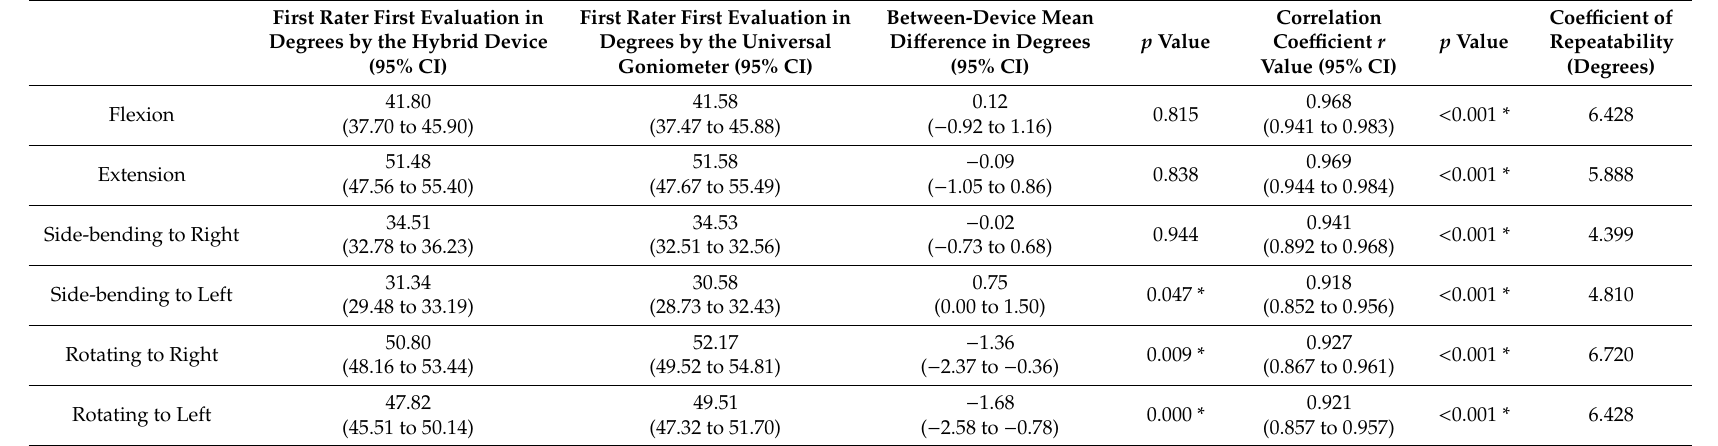
Table 3. Comparisons between the hybrid device and universal goniometer for measurement of craniocervical